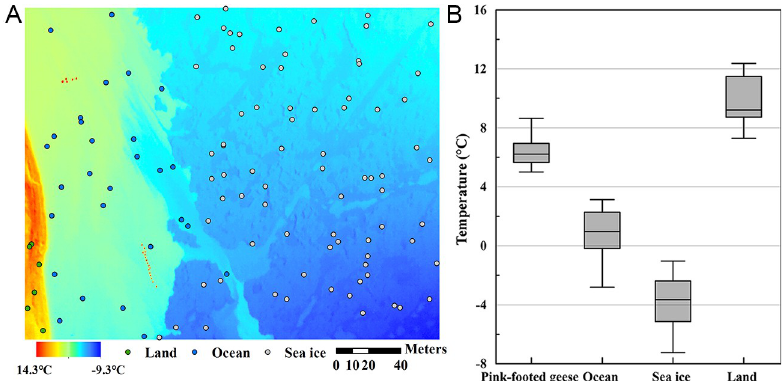
Fig 4. A thermal image including flocks of pink-footed geese and temperature distributions of each group of image pixels. (A) A UAV thermal shot at 110 m high of a goose flock (red dots), ocean (blue circles), sea ice (gray circles) and land (green circles). (B) Temperature distribution of 16 pink-footed geese body shapes and randomly selected dots in each group (ocean, sea ice and land) presented in box-whisker plots (a median line separates the lower- quartile from the upper-quartile, and whiskers extend from the lowest to the highest value) of the temperature distribution of the thermal image pixels in ocean, sea ice, land and pink-footed goose areas.